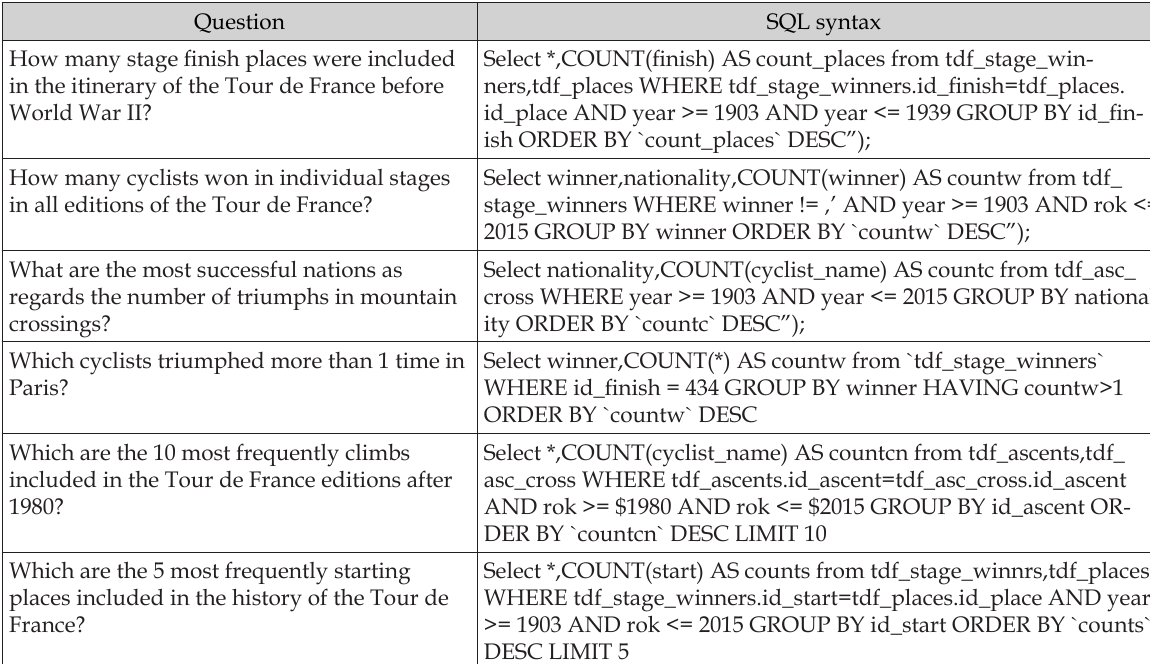
Table 1. Examples of selection of necessary data based on query above database tables.